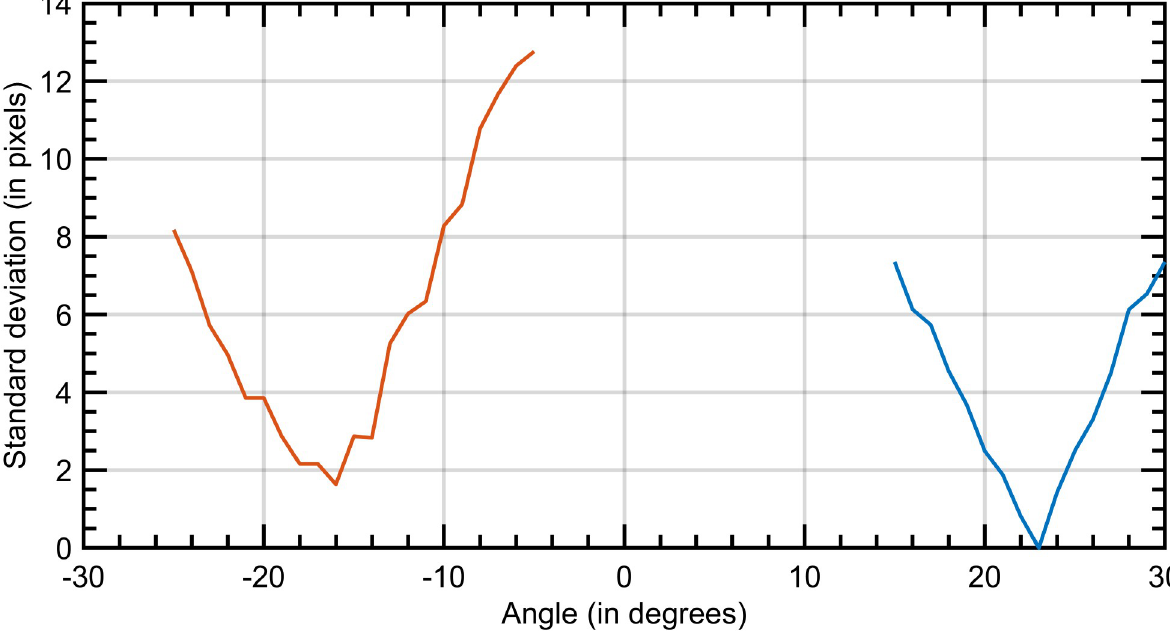
Fig 4. Abscissa: Beam direction (horizontal). Ordinate axis: standard deviations (in pixels) of the centroid positions in x over three CLP-screen distances, for a CLP sample. When this value is minimal, the screen is considered normal to the direction of emission of the VCSEL.